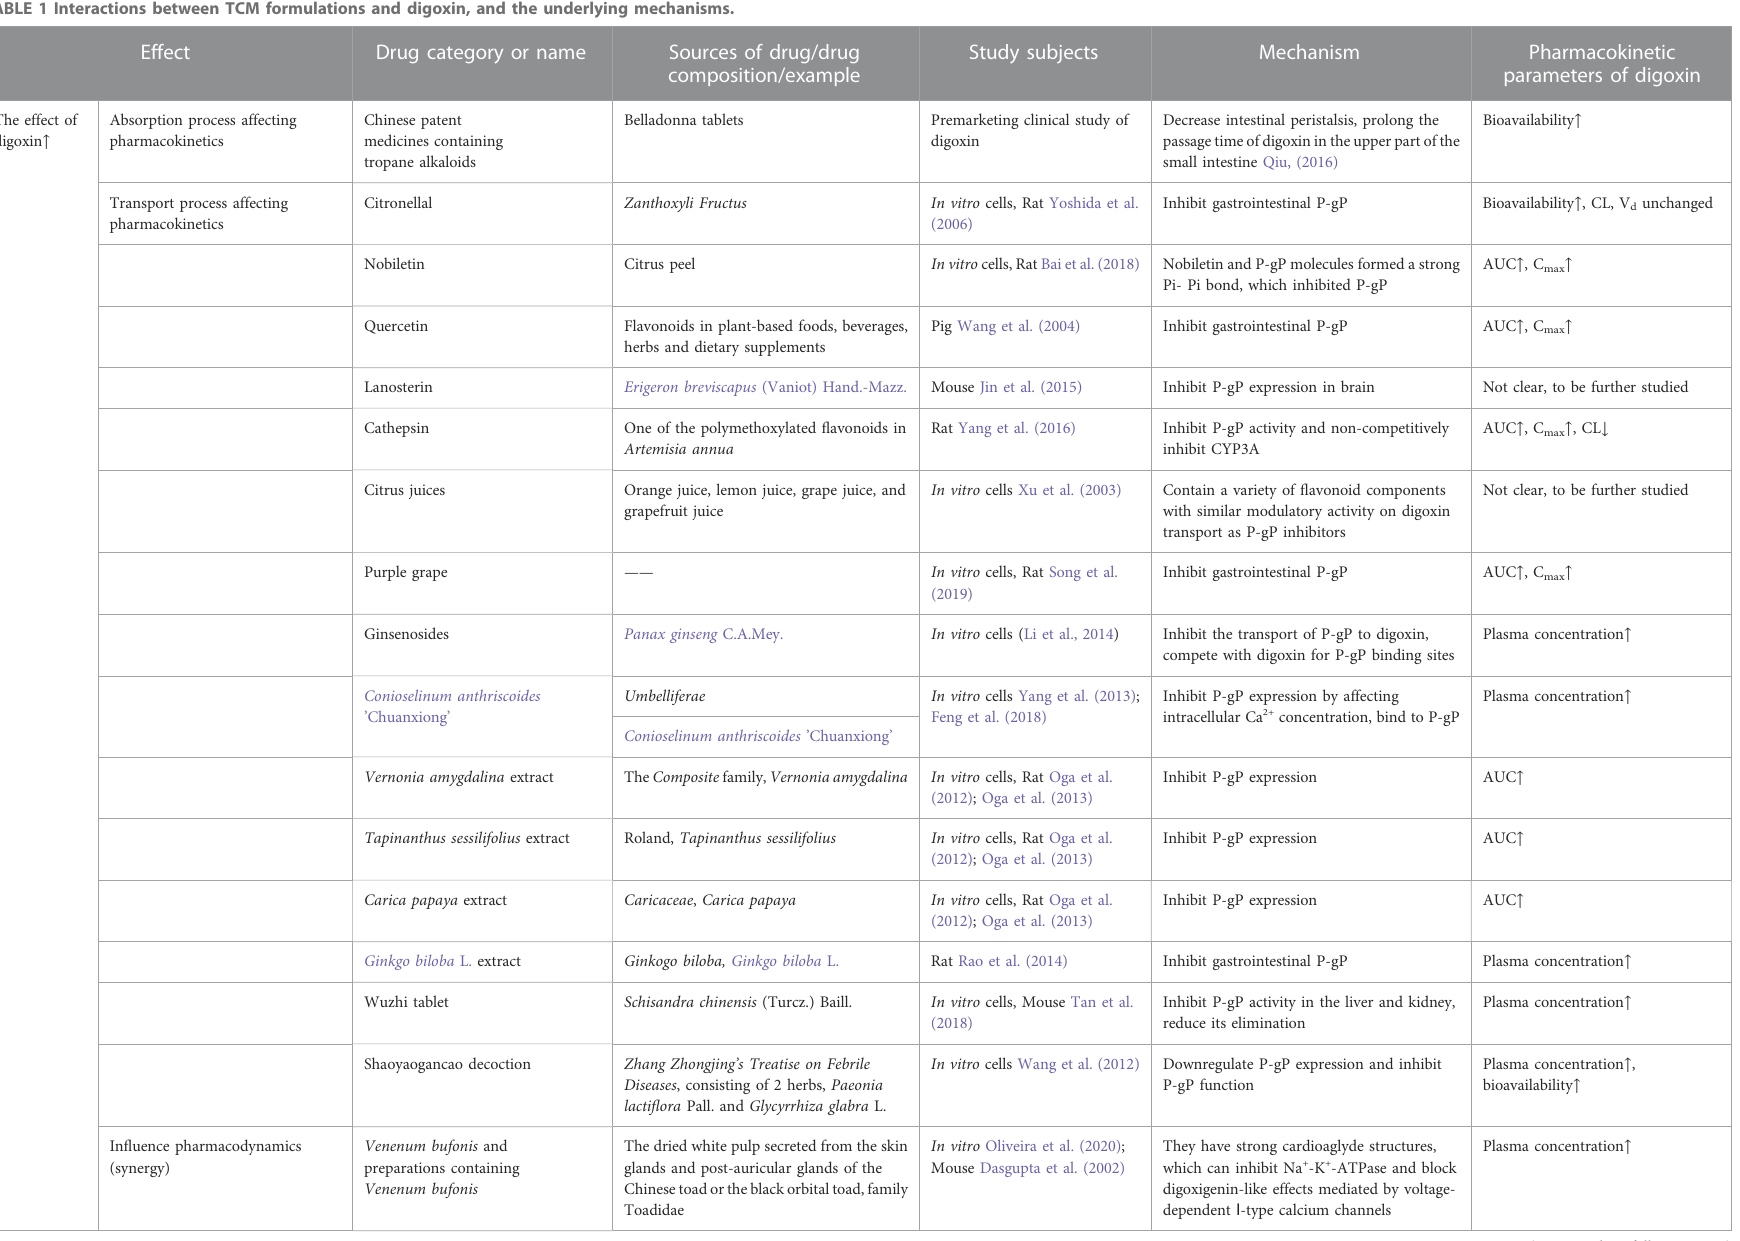
TABLE 1 Interactions between TCM formulations and digoxin, and the underlying